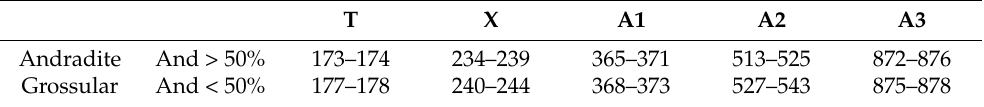
Table 5. The relationship between the garnet end member content and Raman peaks (cm − 1 ). T X